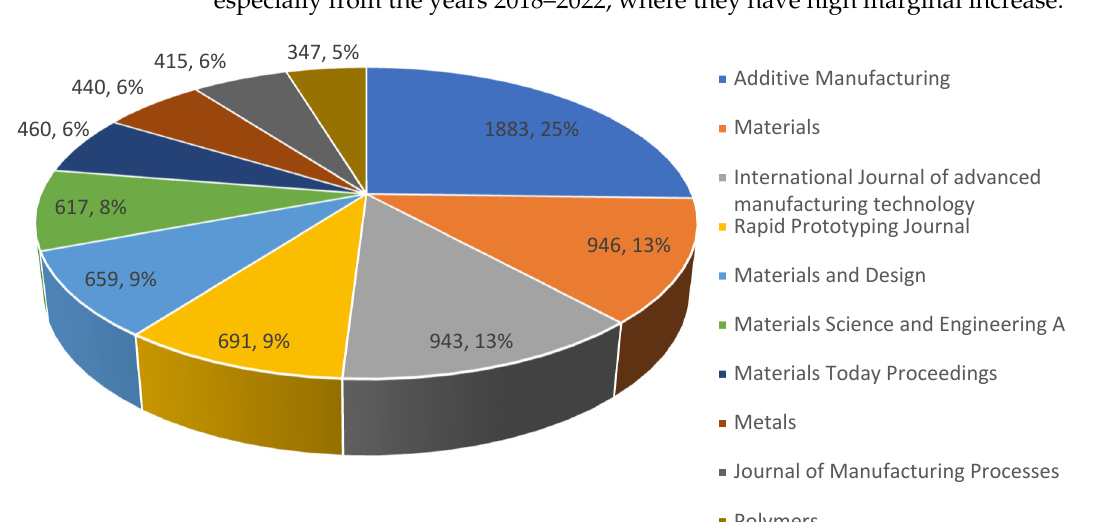
Figure 7. The total number of publications per year by source against percentage of publications from 2001 to 2022 (data retrieved from the Scopus database on 20 June 2022). Note: Each segment shows the number of publications and the corresponding percentages, which is separated by a comma (,) for each publication source.